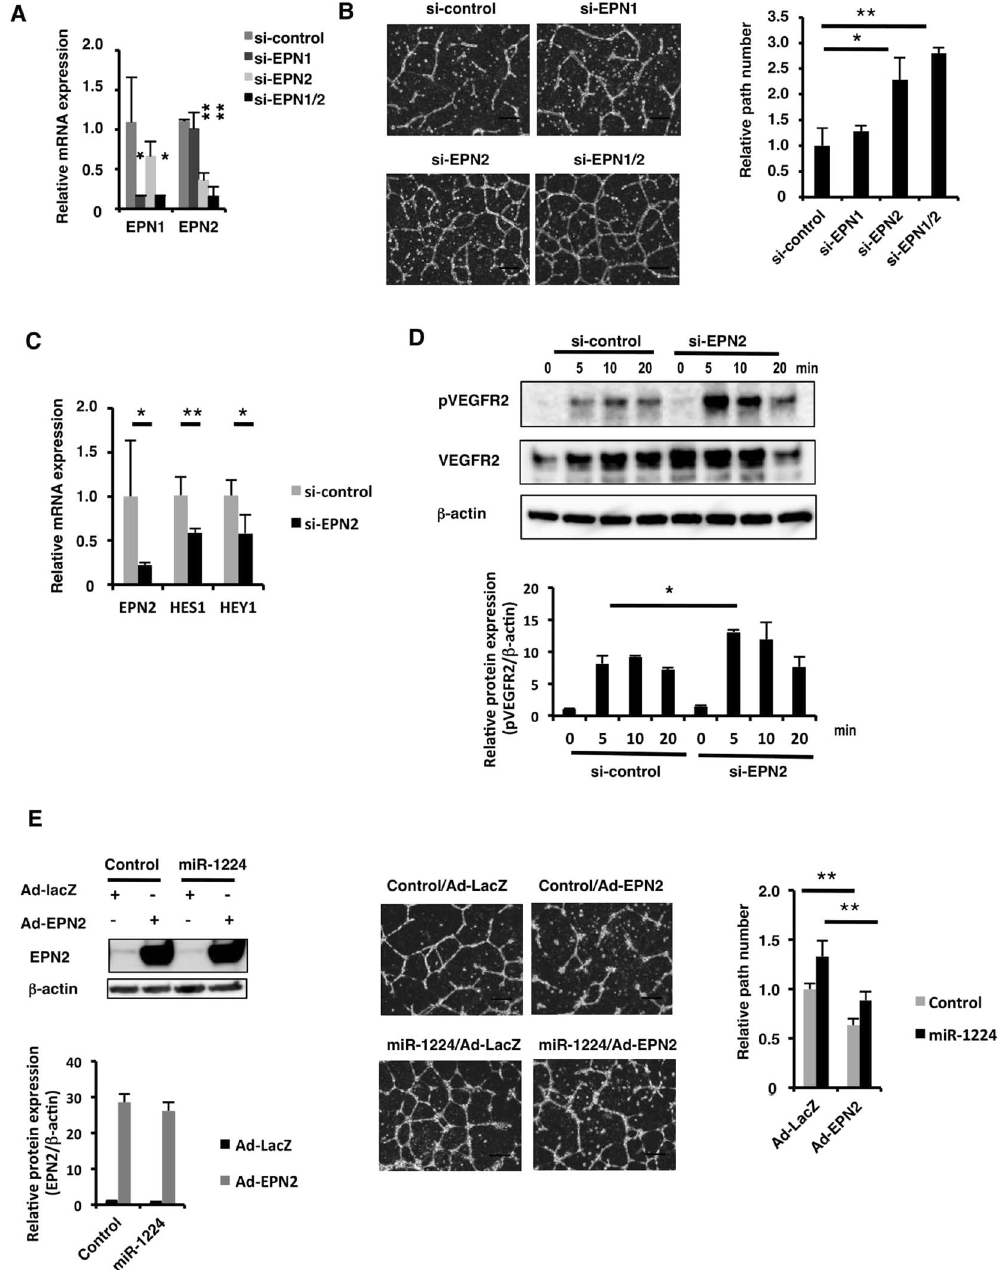
Figure 5. Knockdown of EPN2 stimulated tube formation. ( A ) qRT-PCR analysis of EPN1 and EPN2 mRNA in siRNA-transfected HUVECs. Relative expression to the control siRNA is shown. Bars show the means ± S.D. with * p < 0.05, ** p < 0.01 (n = 3). ( B ) Tube formation assay of siRNA-transfected HUVECs. Scale bars, 300 μ m. Relative path number to the control siRNA-transfection is shown. Bars show the means ± S.D. with * p < 0.05, ** p < 0.01 (n = 3). ( C ) qRT-PCR analysis of HES1 and HEY1 mRNA in siRNA-transfected HUVECs. Relative expression to the control siRNA is shown. Bars show the means ± S.D. with * p < 0.05, ** p < 0.01 (n = 3). ( D ) Western blot analysis of phosphorylated VEGFR2 in HUVECs stimulated with VEGF-A. Uncropped versions of gels are provided in Supplementary Information. The normalized signal intensities were shown as relative values to the control siRNA. Bars show the means ± S.E. with * p < 0.05 (n = 3). ( E ) Tube formation assay of HUVECs transfected with miR-1224 and transduced with EPN2-expressing Ad vector. EPN2 protein expression was analyzed by western blotting (left). Uncropped versions of gels are provided in Supplementary Information. The normalized signal intensities were shown as relative values to the control mimic with the control LacZ- expressing Ad vector. Bars show the means ± S.E. (n =